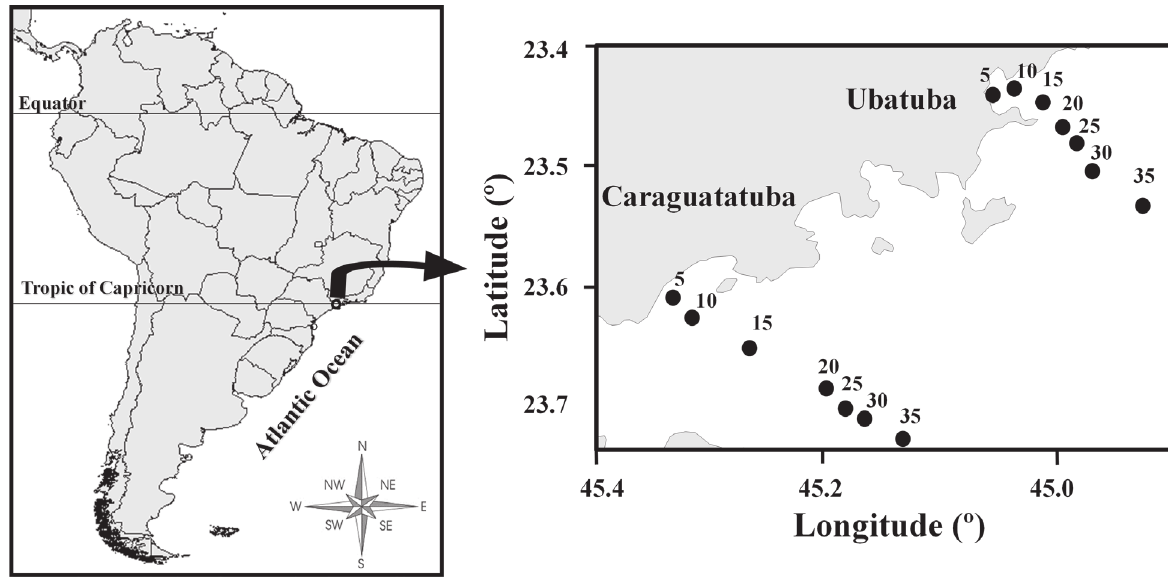
Figure 1 - Location of the Ubatuba and Caraguatatuba regions, indicating the collection